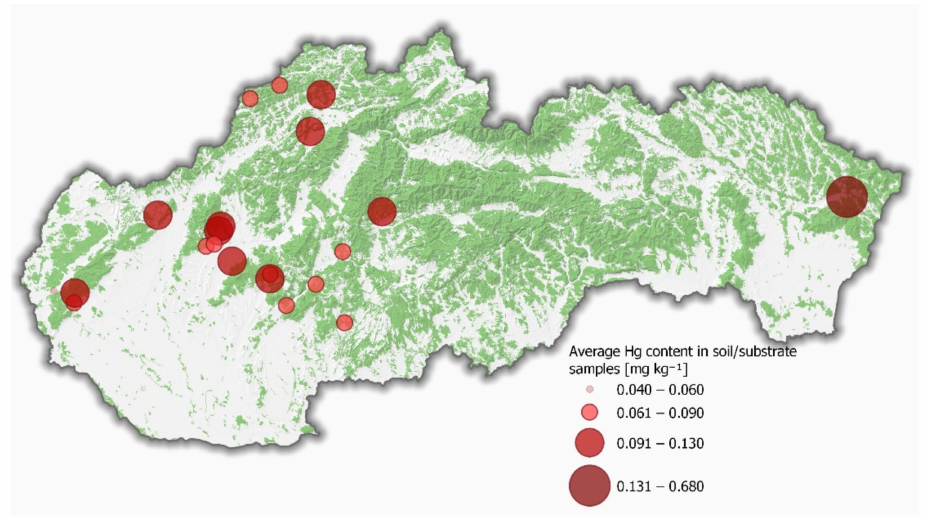
Figure 2. Distribution of mercury content in soil/substrate samples in the sampling